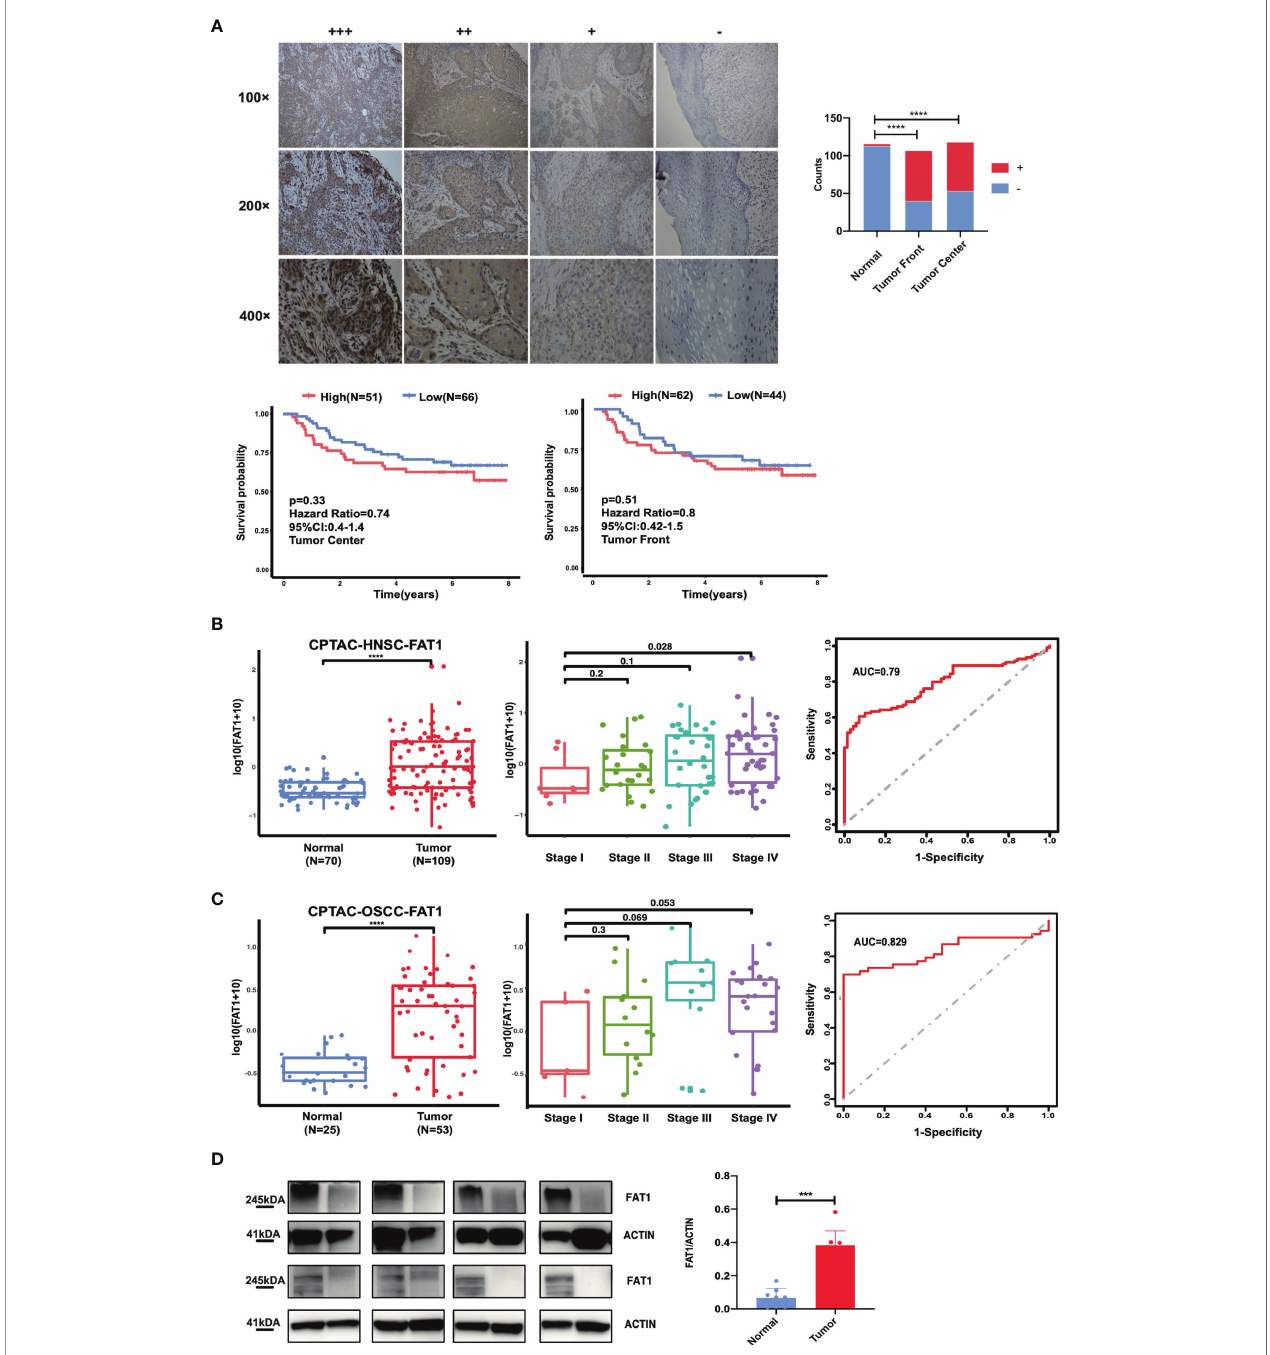
FIGURE 2 | FAT1 protein levels are upregulated in HNSC and OSCC tissues. (A) Left: Representative immunohistochemical staining images of normal and tumor tissues (magni fi cation at ×100, ×200, ×400). FAT1 localization appears as brown staining in the cytoplasm. Right: histogram of the proportion of the FAT4 staining levels among the tumor front, tumor center, and adjacent normal samples and Kaplan – Meier survival analysis of patients with high and low levels of FAT1 protein expression by immunohistochemical staining levels. A high FAT1 expression exhibited poor survival but not signi fi cantly (P > 0.05). (B) FAT1 protein expression status between normal tissues and tumor tissues in HNSC from CPTAC (boxplot); FAT1 protein expression status among high stage and stage I tumor tissues in HNSC from CPTAC (boxplot); areas under the curve (AUCs) of the ability to discriminate normal tissues and tumor tissues by the FAT1 protein level in HNSC from CPTAC. (C) FAT1 protein expression status between normal tissues and tumor tissues in OSCC from CPTAC (boxplot); FAT1 protein expression status among high stage and stage I tumor tissues in OSCC from CPTAC (boxplot); areas under the curve (AUCs) of the ability to discriminate normal tissues and tumor tissues by the FAT1 protein level in OSCC from CPTAC. (D) FAT1 protein expression status in clinical samples (bar plot). ***P < 0.001; ****P <